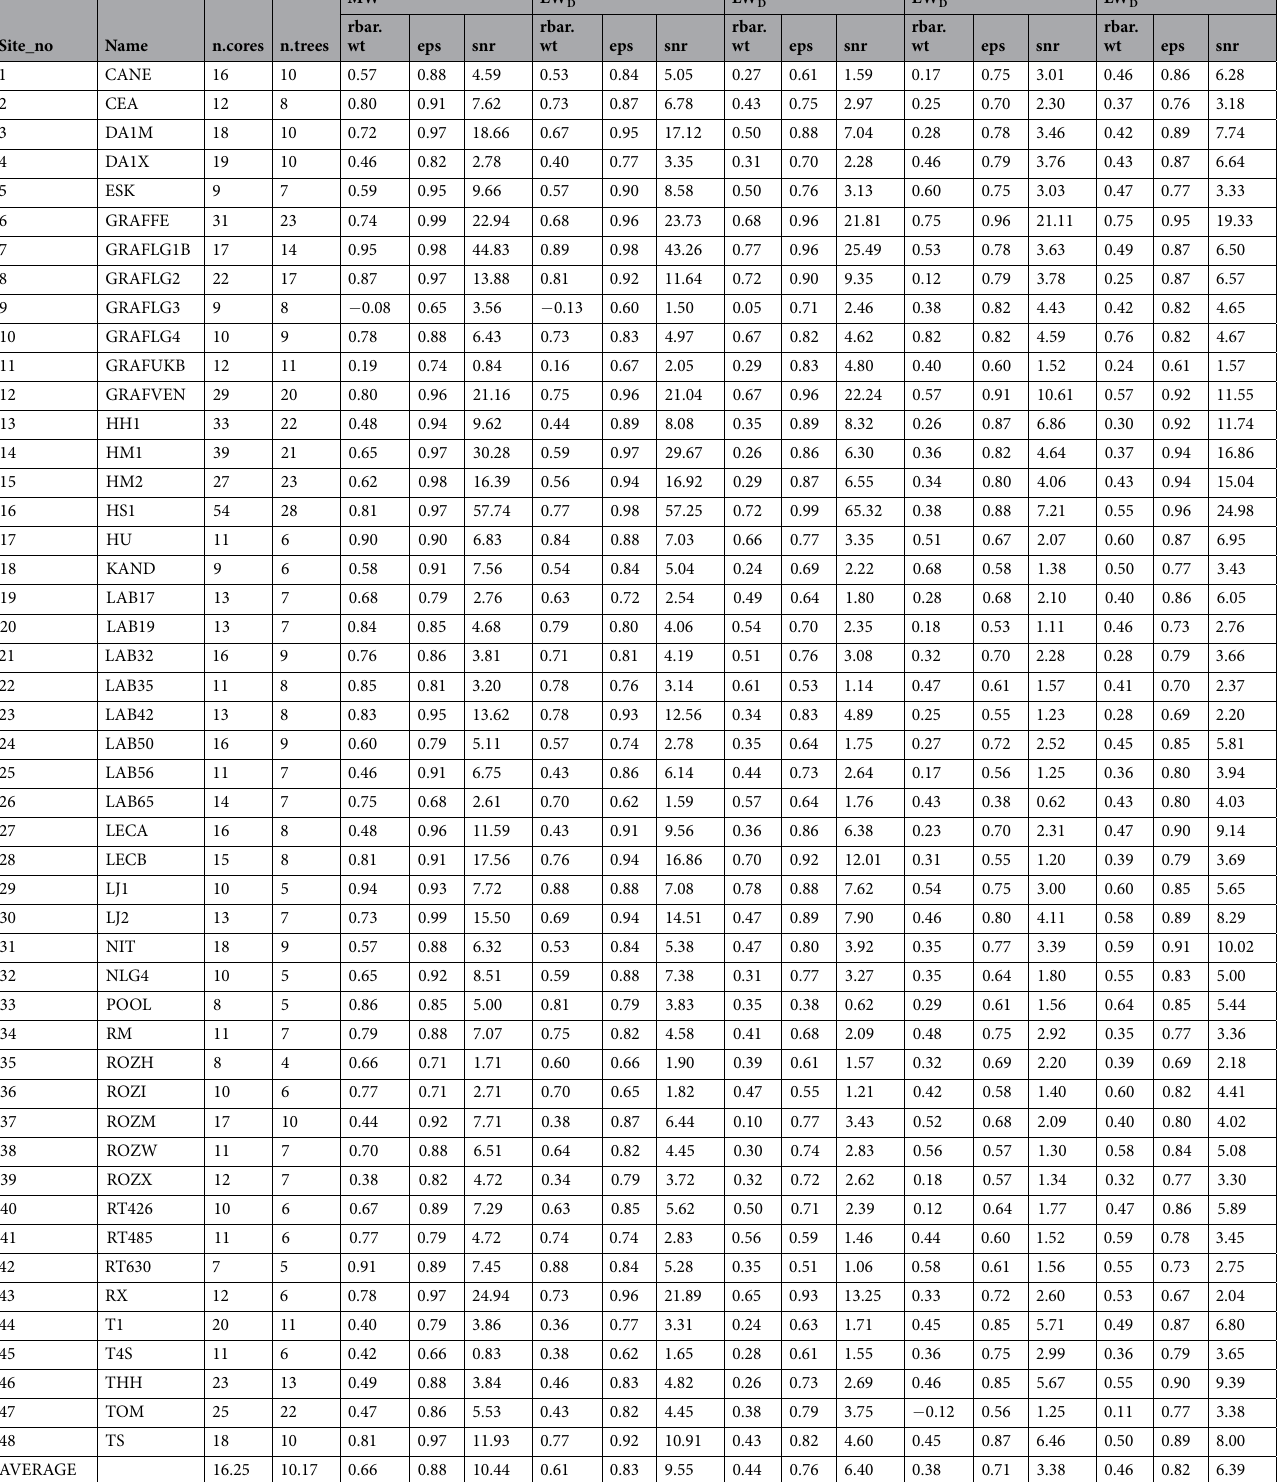
Table 1. Dendroecological information and statistics describing the tree ring network: number of cores and number of trees sampled at each site, Expressed Population signal (eps), Signal-to-noise ratio (snr) and mean correlation between one tree and all remaining trees (rbart.